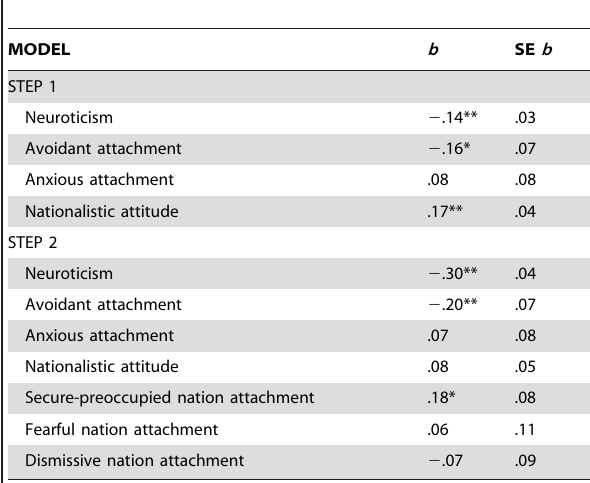
Table 8. Association of Nation Attachment with SWB (Study 2).